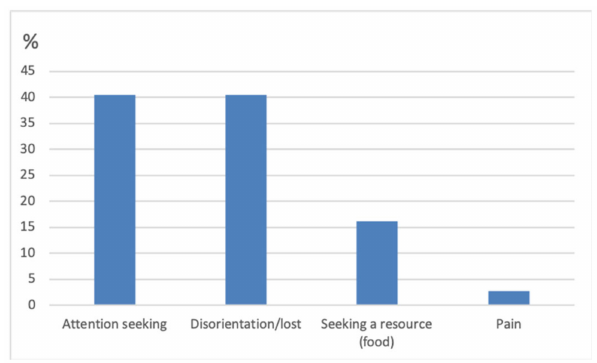
Figure 3. Bar chart illustrating the owners perceived main cause of